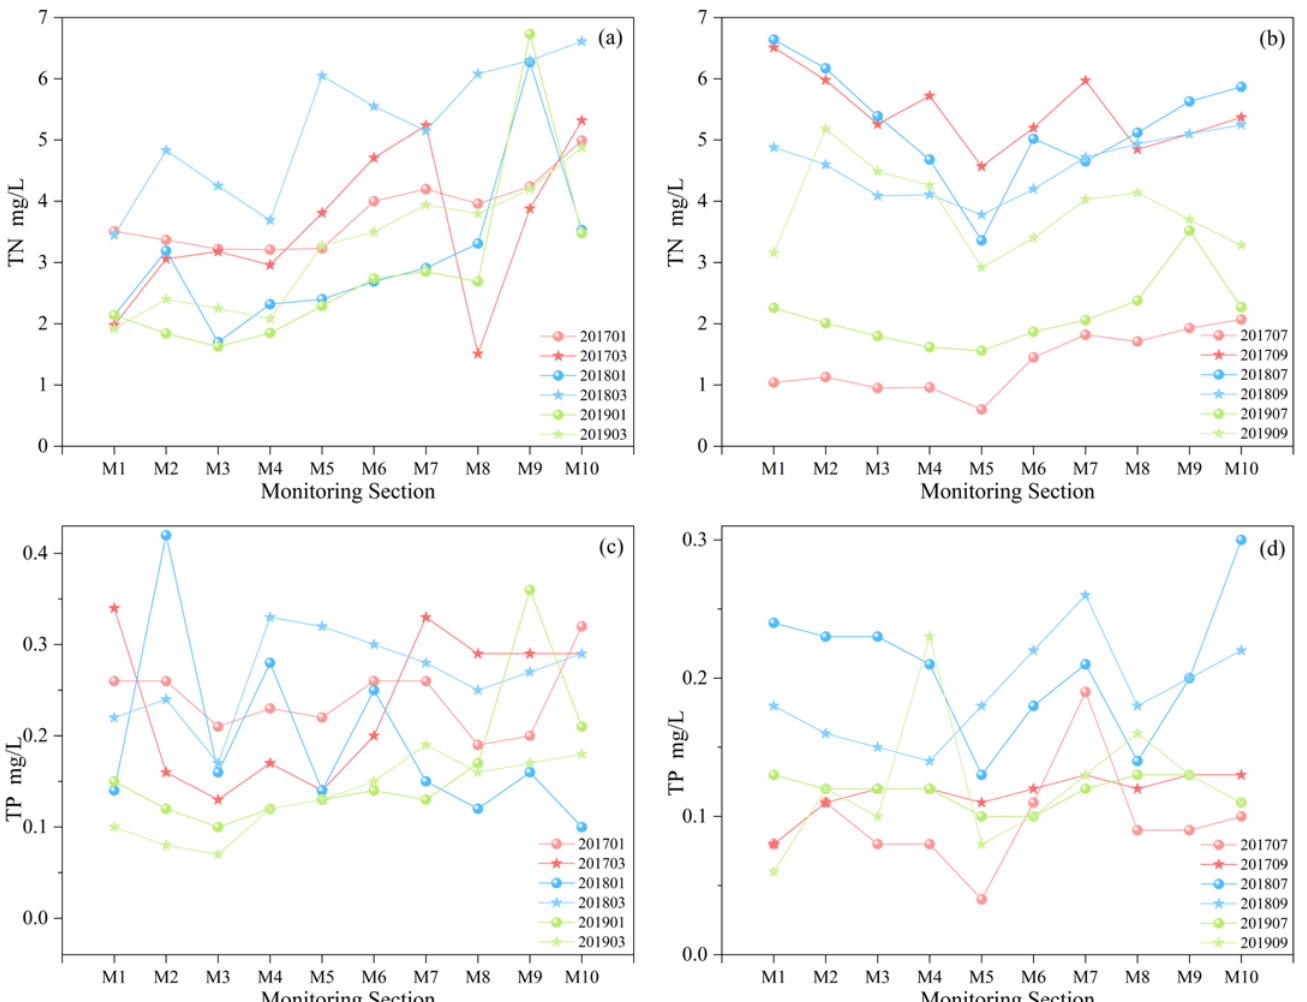
Figure 6. Distribution of TN and TP concentrations at each monitoring section. TN in dry season ( a ), TN in wet season ( b ), TP in dry season ( c ), TP in wet season ( d ).